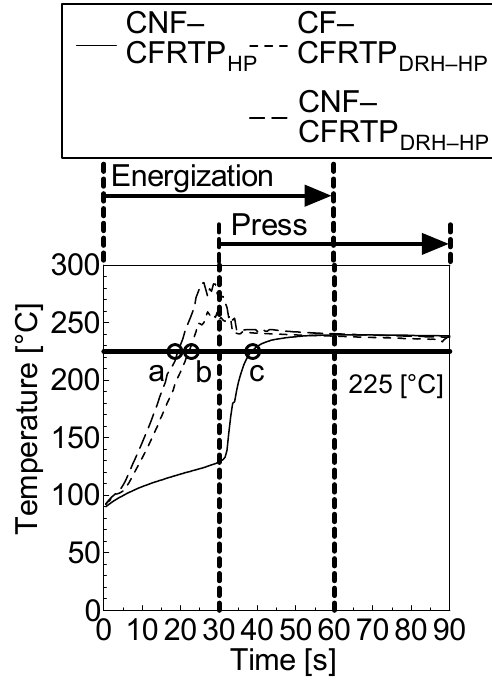
Figure 13. Temperature history of CF-CFRTP and Figure 13 . Temperature history of CF-CFRTP and CNF-CFRTP.